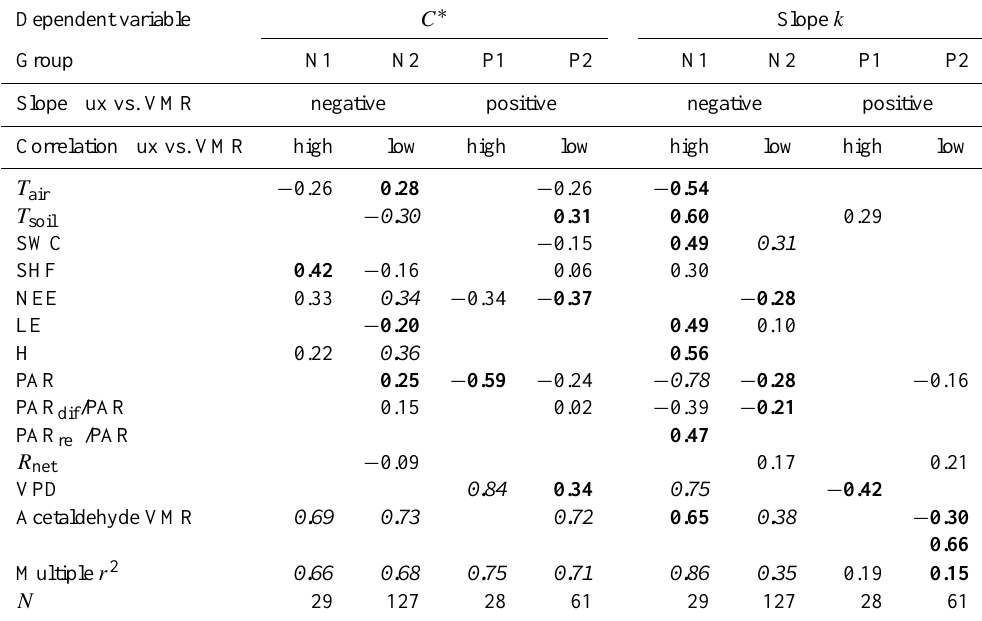
Table 2. Partial correlations of forward stepwise multiple linear regression analyses of the compensation point ( C ∗ ) and slope k calculated per day from half-hourly acetaldehyde VMR and flux values, using daily average values of air temperature ( T air ) , soil temperature ( T soil ) and soil water content (SWC) in 5cm depth, soil heat flux (SHF), net ecosystem CO 2 exchange (NEE), latent (LE) and sensible (H) heat flux, photosynthetically active radiation (PAR), fraction of diffuse (PAR dif /PAR) and reflected (PAR refl /PAR) PAR, total net radiation ( R net ) , vapor pressure deficit (VPD) and acetaldehyde volume mixing ratios (VMR). Bold numbers highlight p < 0 . 05, except italic numbers resulted in p < 0 . 001. Groups represent direction of correlation and goodness of fit between acetaldehyde VMR and flux: N1...negative slope, r 2 > 0 . 2, N2...negative slope, 0 . 05 < r 2 < 0 . 2, P1...positive slope, r 2 > 0 . 2, P2...positive slope, 0 . 05 < r 2 < 0 . 2. All management data were excluded from the